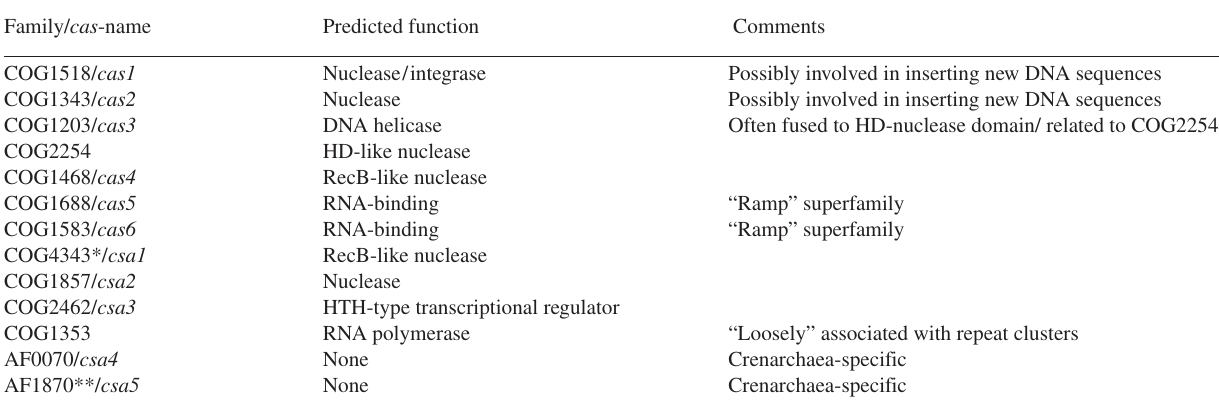
Table 4. Predicted functions of common cas -genes in archaea. Data are summarized from Makarova et al. 2006 and earlier papers (Jansen et al.